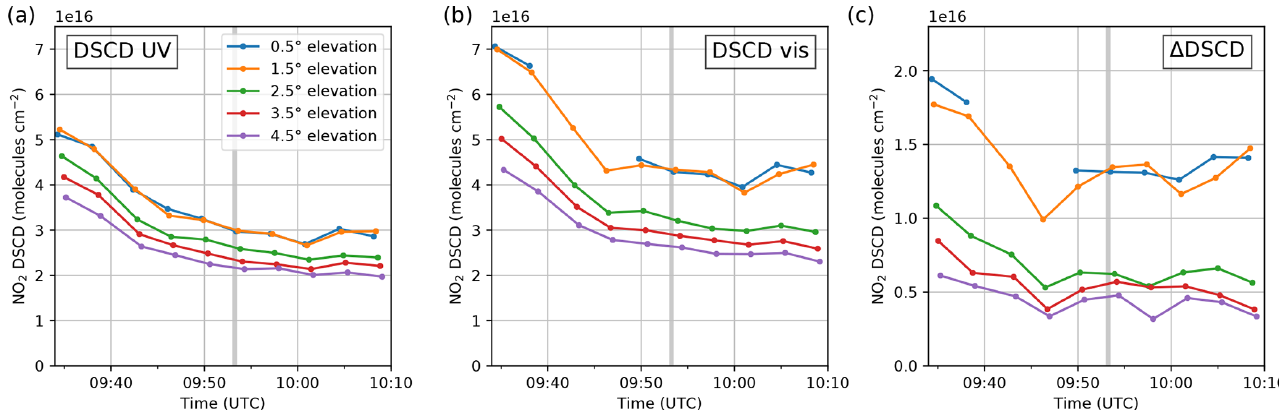
Figure 9. MAX-DOAS differential slant column densities of NO 2 in the UV (a) and visible (b) spectral ranges as well as their difference (cid:49) DSDC (c) for the five lowest elevation angles for the azimuthal viewing direction of 335 ◦ . The vertical gray line indicates the AirMAP plume overpass